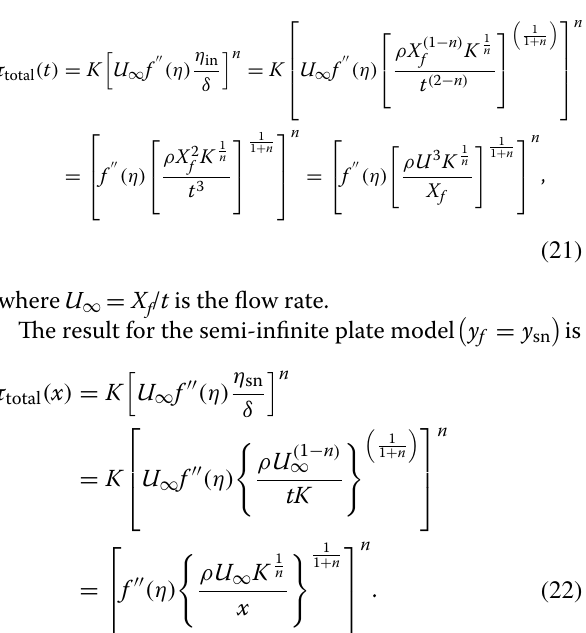
′′ (η) at ′ (η) . models using the equations derived above are shown in Fig. 5a and b, respectively. For any n , the graph is convex.